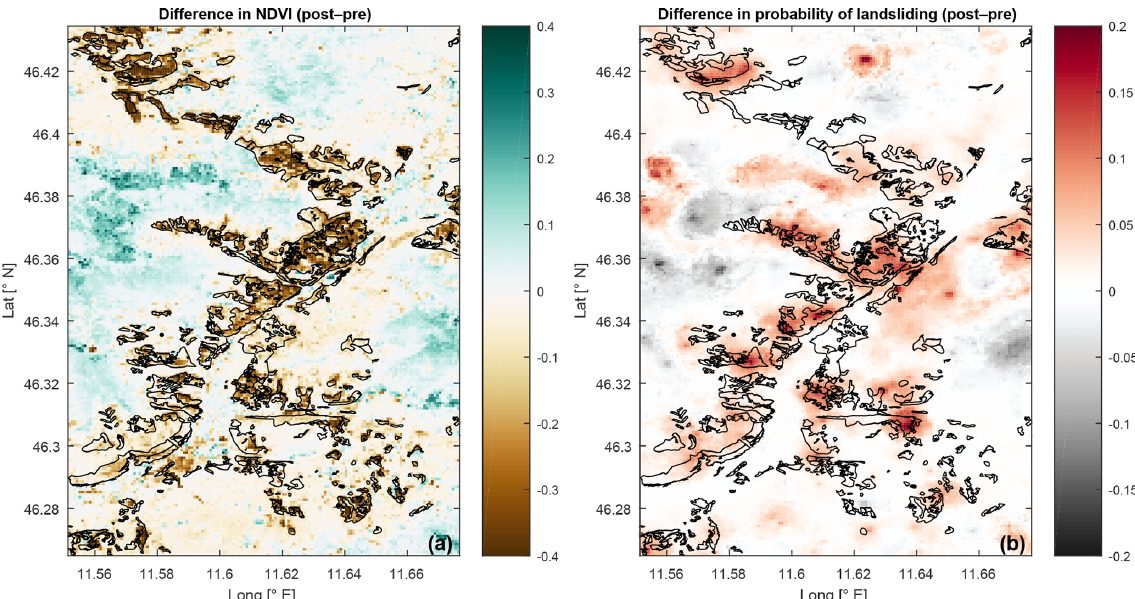
Figure 8. Analysis of the indirect effects of wind damage on slope instability. Changes in NDVI and probability of landsliding following windstorm Vaia of October 2018 in the Dolomites in northern Italy, shown in (a) and (b) , respectively. Black polygons show the actual wind